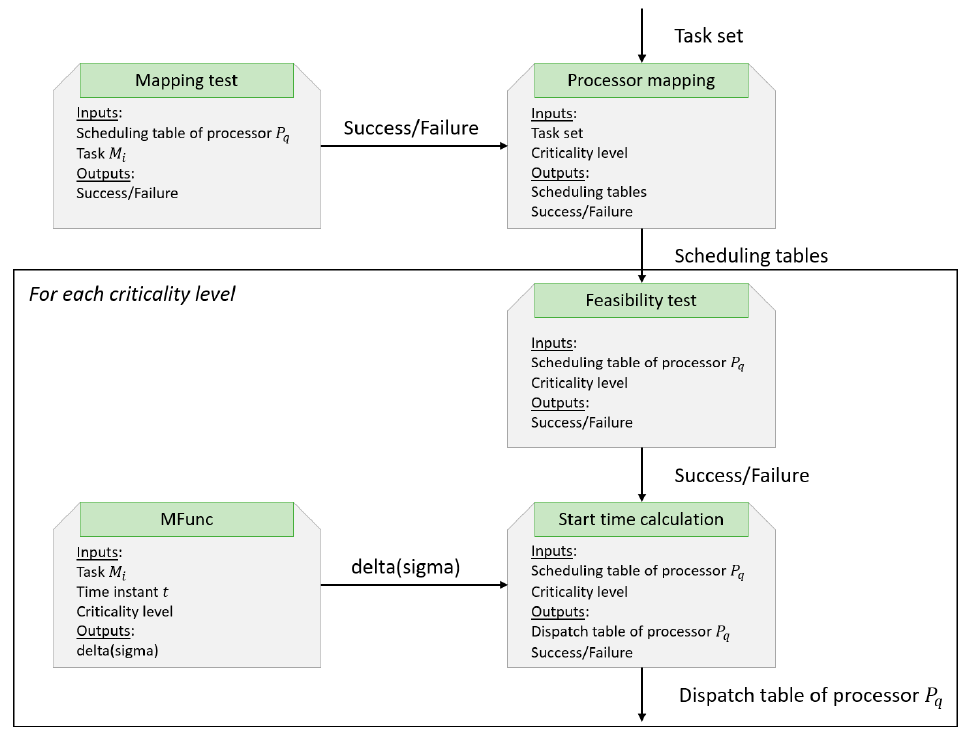
Figure 6. O ffl ine phase Figure 6. Offline phase execution.